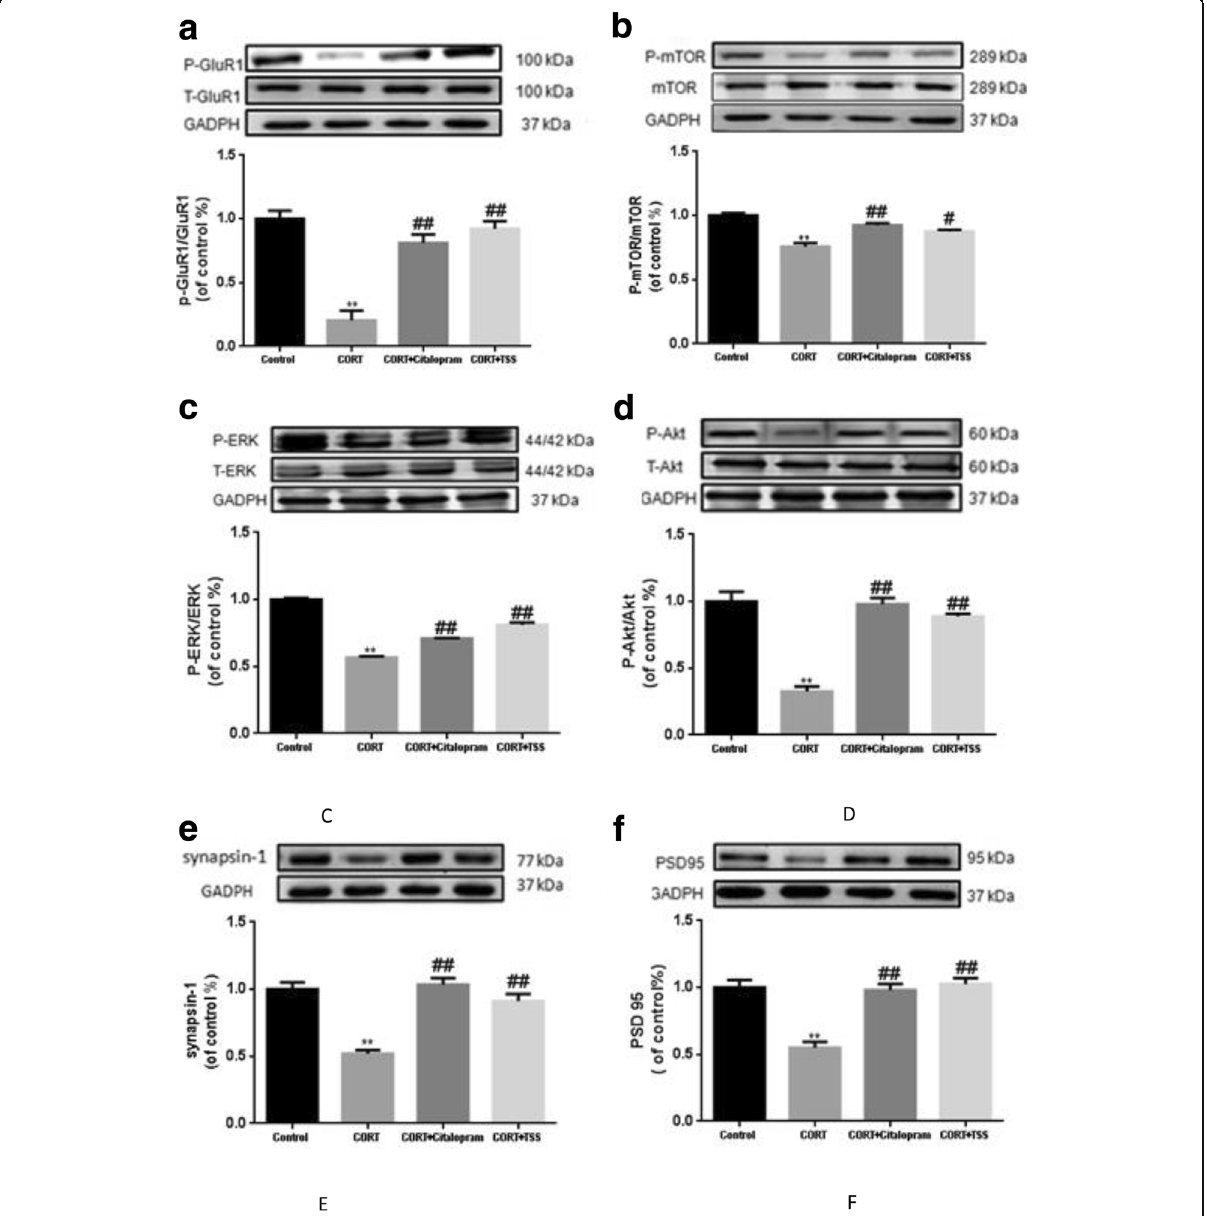
Fig. 7 Representative western blot analysis of P-GluR1( a ), P-mTOR ( b ), P-ERK ( c ), P-Akt ( d ), synapsin-1( e ) and PSD-95 ( f ) in the hippocampus after TSS (25 mg/kg) and citalopram (10 mg/kg) treatment in chronic corticosterone-treated mice. Data were analyzed by one-way ANOVA followed by Student-Newman-Keuls test. Each bar represents the mean ± SEM. ** P < 0.01, as compared with the control group and ## P < 0.01, # P < 0.05, as compared with the CORT